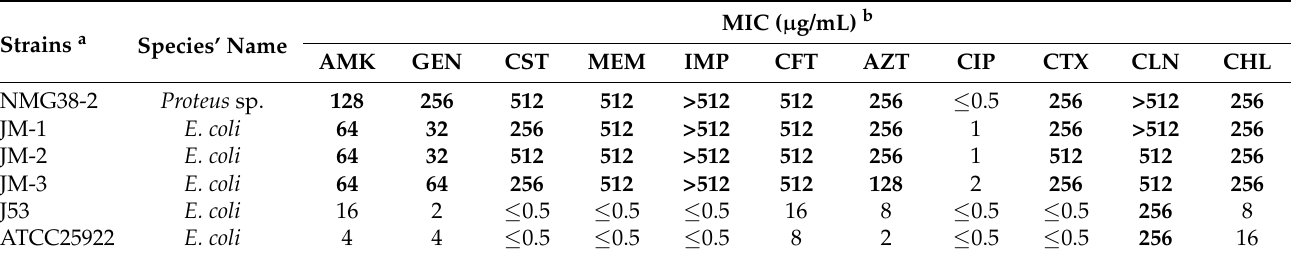
Table 1. MICs for NMG38-2, its transformants, and the recipient strain J53.